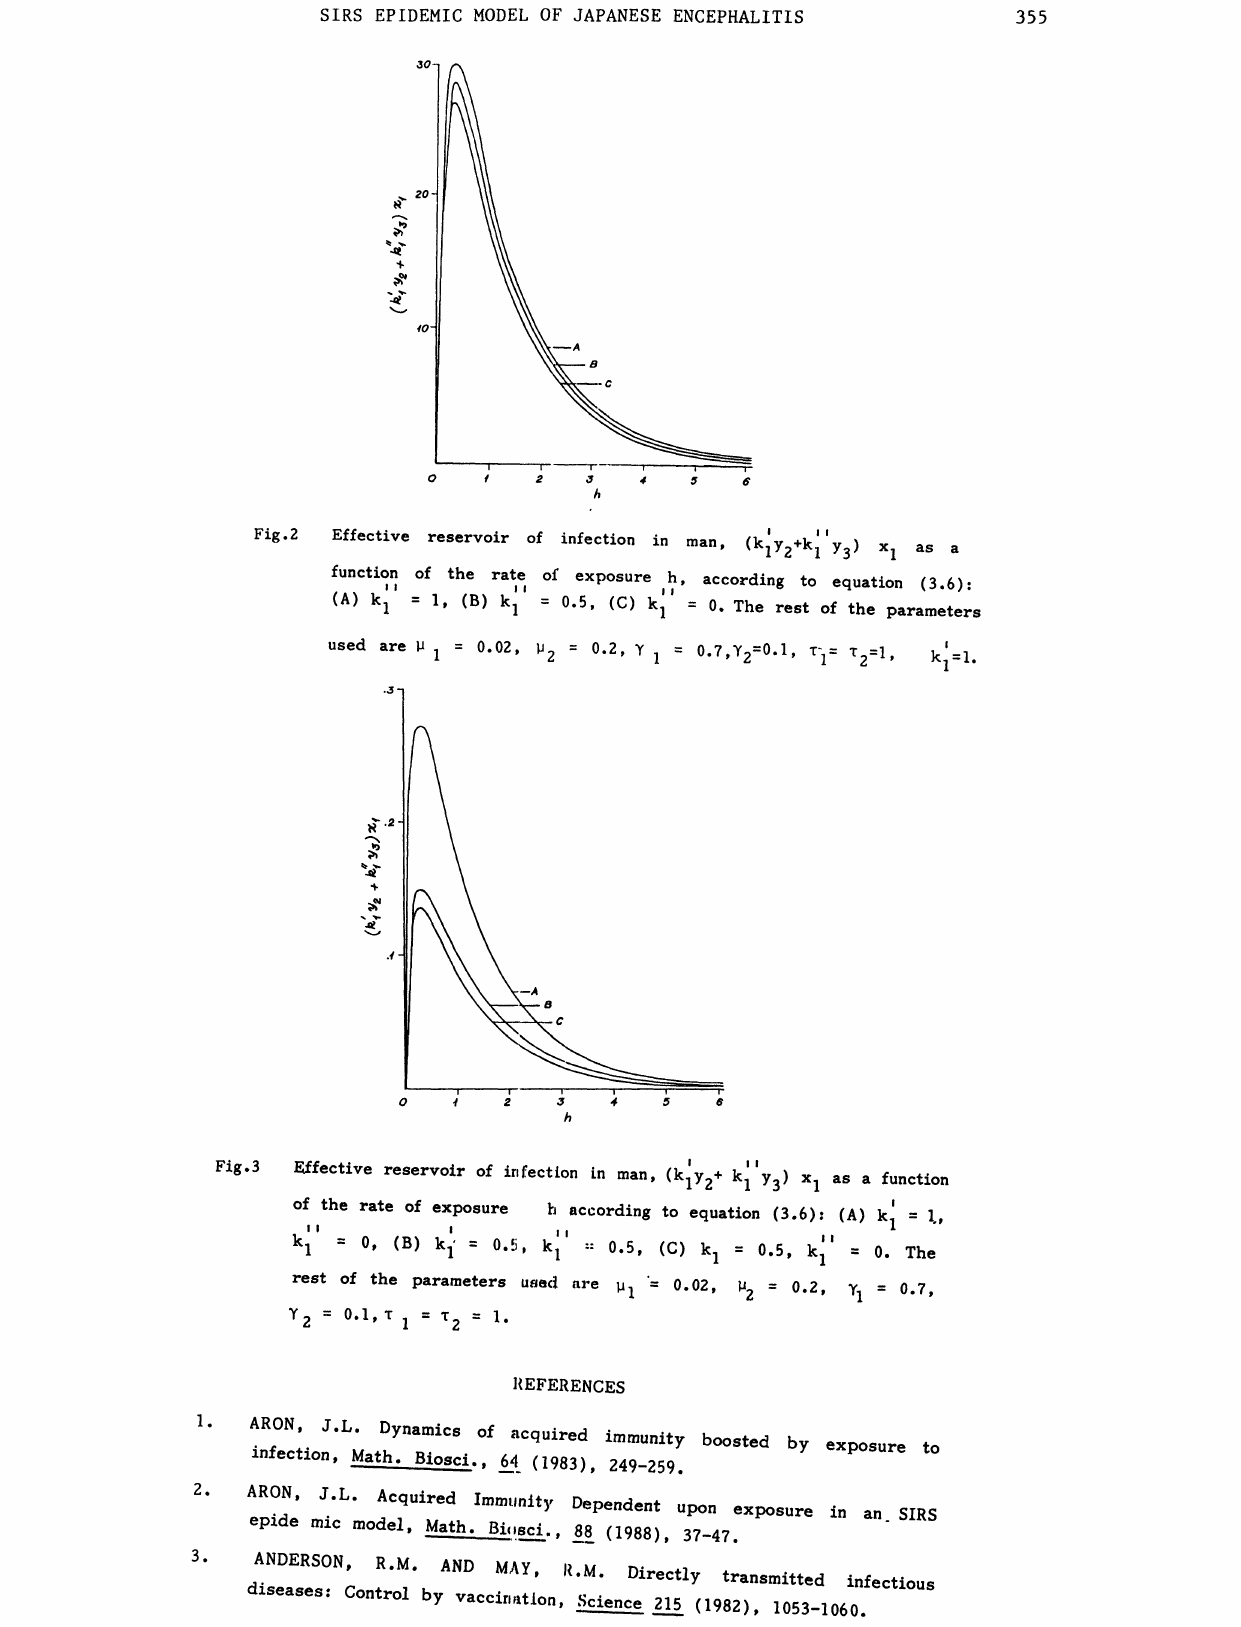
Xl as a function (A) k l., k The 0.7,